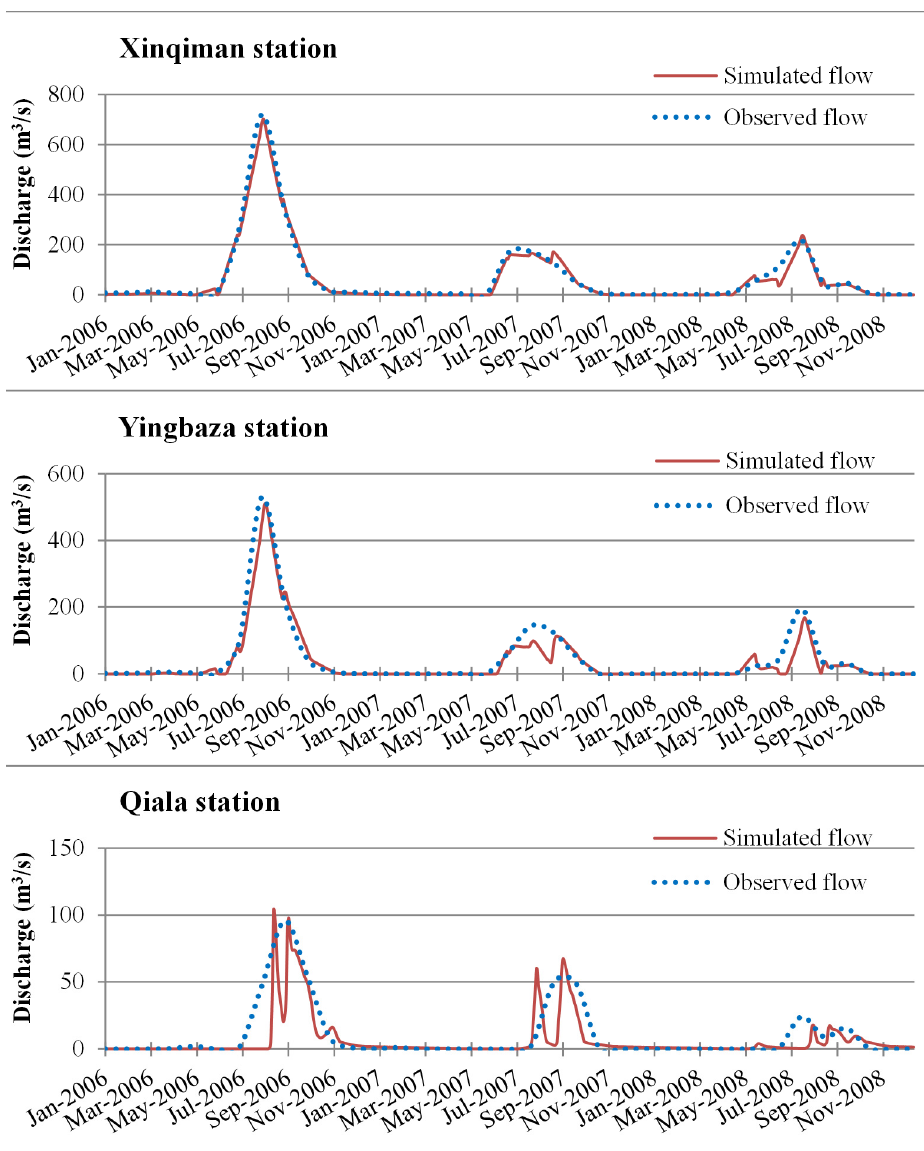
Figure 4. Observed and simulated discharge from three gauging stations: